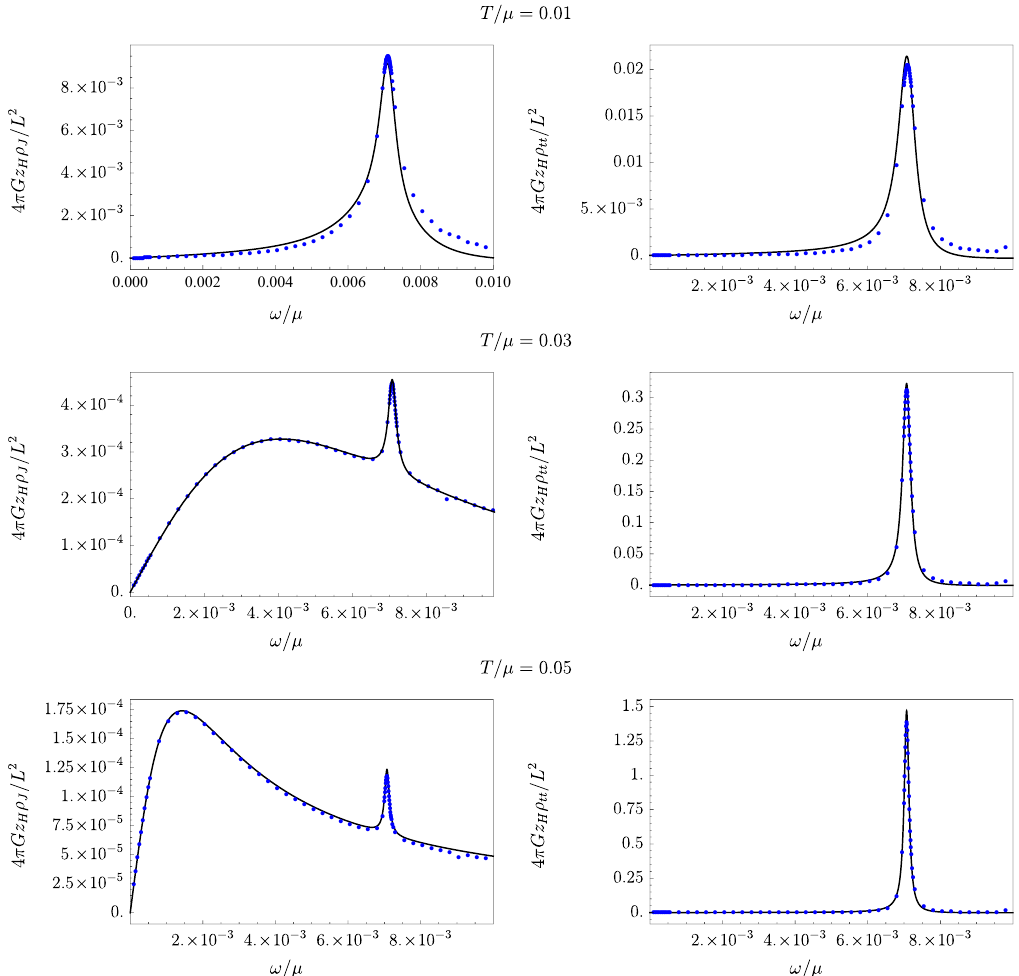
Figure 13. Our numerical results (blue dots) for the charge spectral function, (cid:26) J (left column) and energy spectral function, (cid:26) tt (right column), each made dimensionless by a factor of 4 (cid:25)Gz H =L 2 , as functions of !=(cid:22) for (cid:28) = 10 (cid:0) 4 , ~ (cid:11) = 1, k=(cid:22) = 10 (cid:0) 2 and T=(cid:22) = 10 (cid:0) 2 (top row), 0 : 03 (middle row), and 0 : 05 (bottom row). The solid black lines come from the sum-of-poles approximation to the Green’s functions in eq. (3.6). Both (cid:26) J and (cid:26) tt exhibit a peak from the sound pole (HZS p or hydrodynamic) at ! (cid:25) k= 2. As T=(cid:22) increases the sound peak’s height decreases in (cid:26) J but increases in (cid:26) tt . Simultaneously, in (cid:26) J a second peak rises near !=(cid:22) = 0, from the charge di(cid:11)usion pole, while (cid:26) tt exhibits no other signi(cid:12)cant features. The crossover can be de(cid:12)ned as the value of T=(cid:22) where the two peaks in (cid:26) J have equal height [33], which gives T=(cid:22) = 0 : 039. (Animated versions of these (cid:12)gures are available on this paper’s arxiv